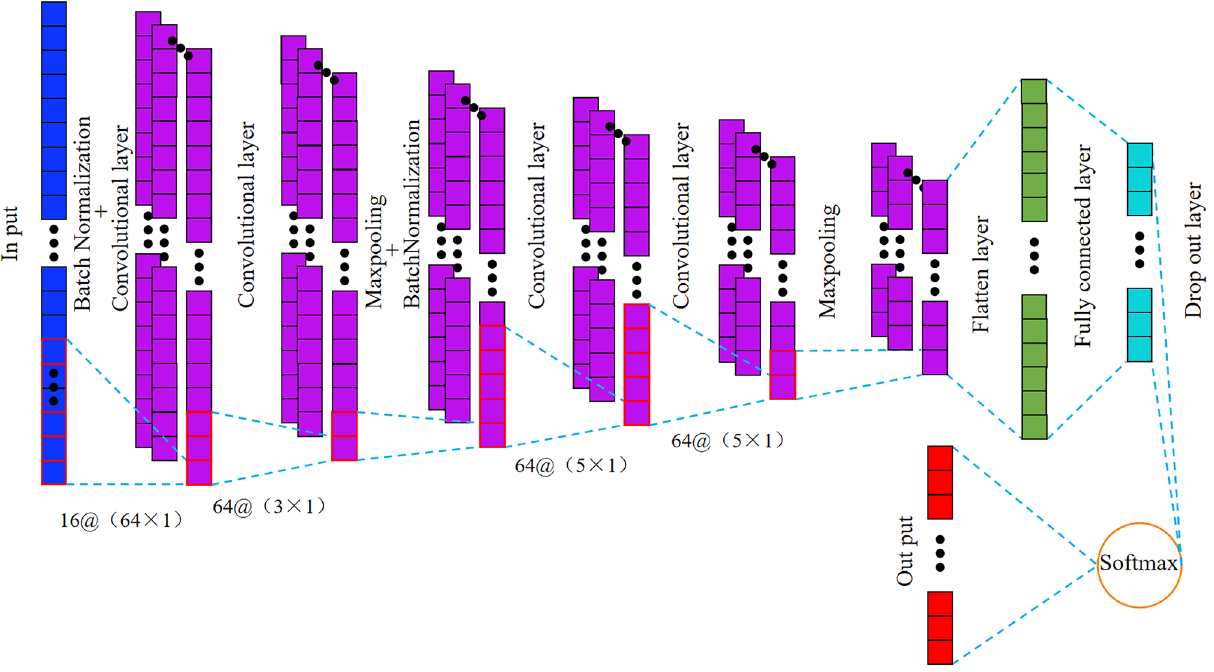
Figure 2. Structure of feature